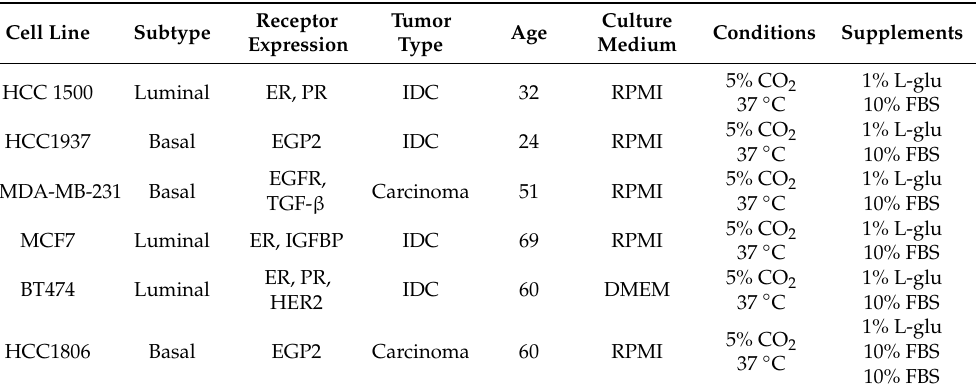
Table 2. Cell lines characteristics and culture